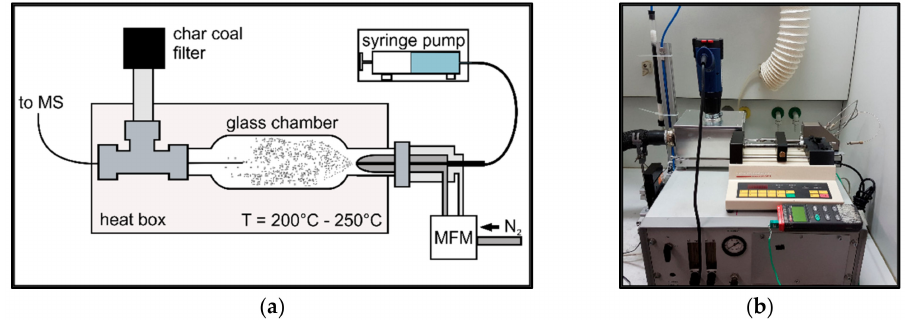
Figure 2. ( a ) Experimental setup of the sample introduction system for (semi-)volatile organic compounds; standard solutions, containing known amounts of compounds, are introduced into a nebulizer via syringe pump and sprayed into a heated glass chamber. The evaporated analytes are transferred via a heated transfer line into the ion source of the mass spectrometer. ( b ) Photograph of the introduction